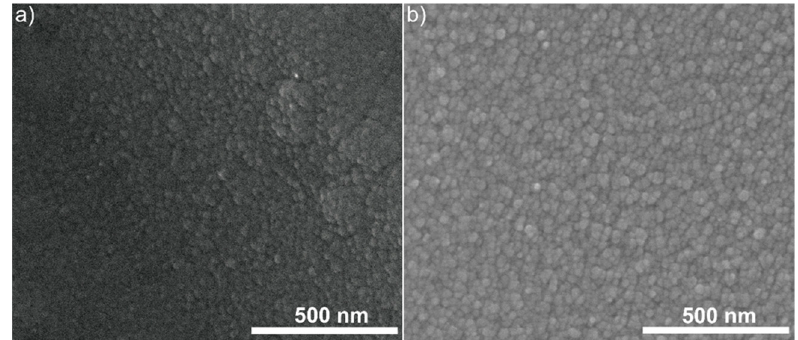
Figure 6. Scanning electron microscopy (SEM) micrographs of Ag:HAp-S1 ( a ) and Ag:HAp-S2 ( b ) composite layers.